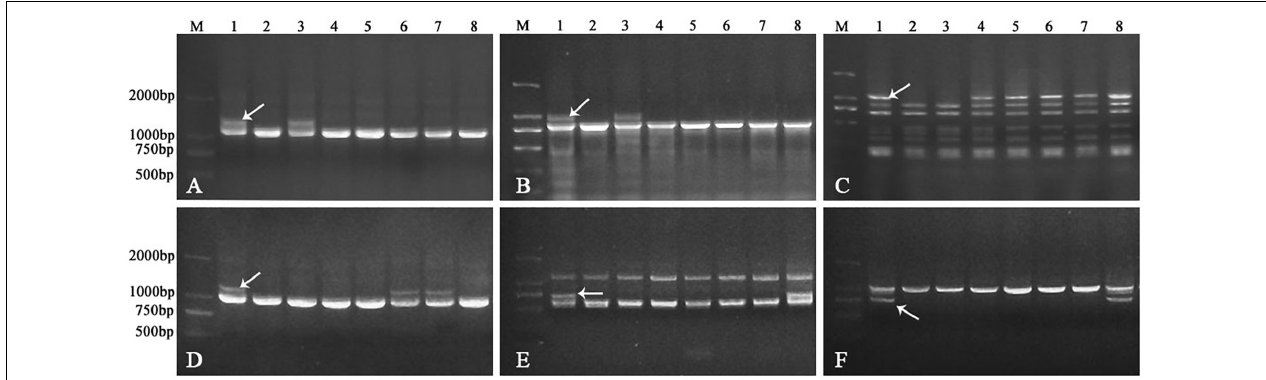
FIGURE 4 | PCR patterns of primer pair TNAC1137 (A) , TNAC1197 (B) , TNAC1398 (C) , TNAC1740 (D) , TNAC1867 (E) , and TNAC1924 (F) . Lane M indicates Marker DM2000. Lanes 1-8 in panels (A–F) are CS -A. sharonensis amphiploid , CS, CS- A . sharonensis 2S sh disomic addition, 4S sh disomic addition, 4S sh (4D) substitution + 5S sh L monotelosomic addition, 6S sh disomic addition, 4S sh (4D) substitution + 6S sh disomic addition and 4S sh (4D) substitution + 7S sh disomic addition lines,